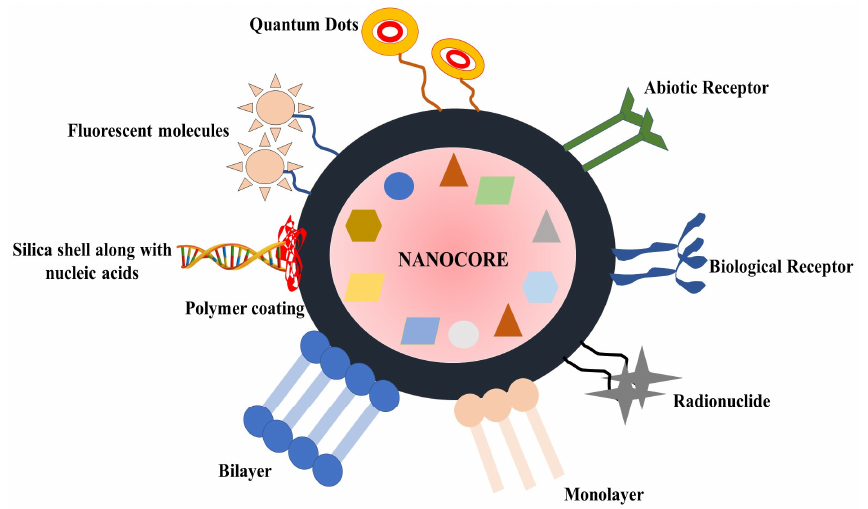
Figure 4. Schematic diagram representing multifunctional nanoparticle.